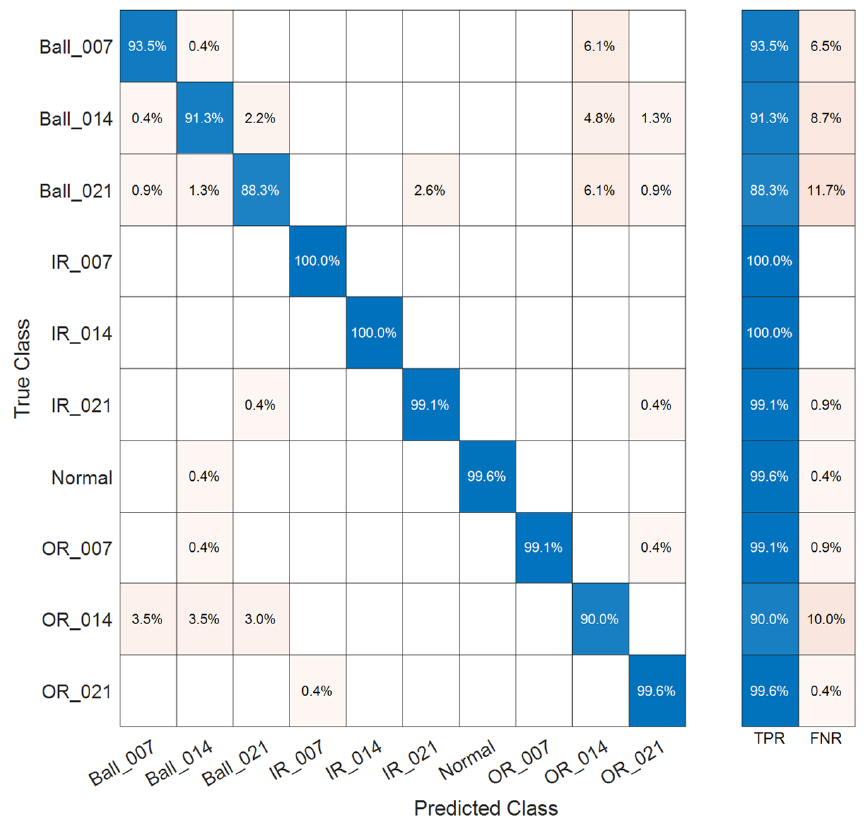
Figure 8. Confusion matrix of motor bearing failure prediction in coarse Gaussian SVM, with a total accuracy of 93.6%.